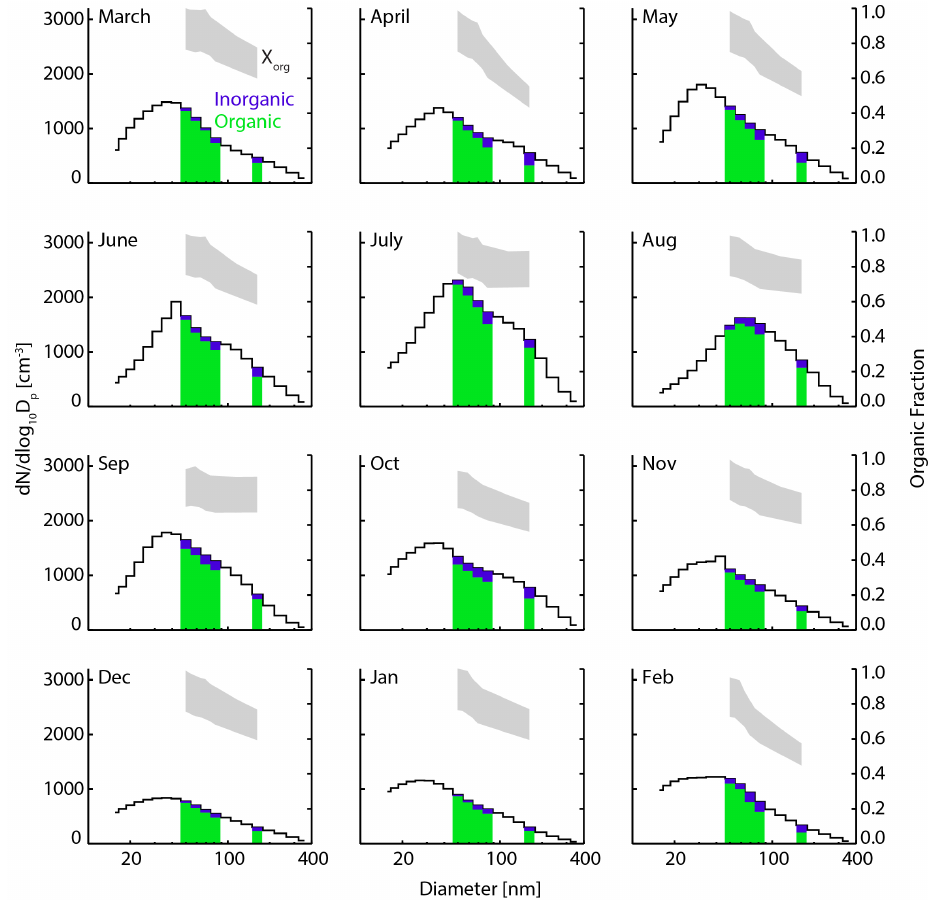
Fig. 5. Monthly averaged aerosol size distributions (black) and two-component chemical composition (green=organic, blue=inorganic) calculated from hygroscopicity measurements during the year-long BEACHON study. Gray shading shows the range in organic mass fraction ( X org ) due to uncertainty in κ org